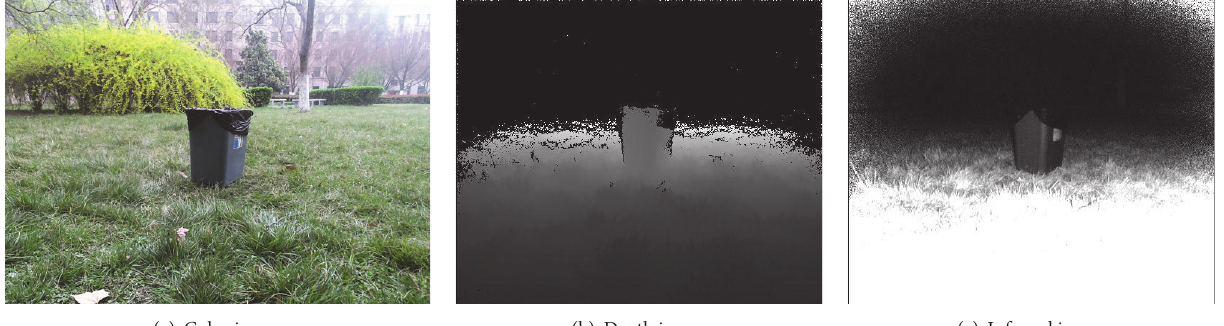
Figure 2: The grassland